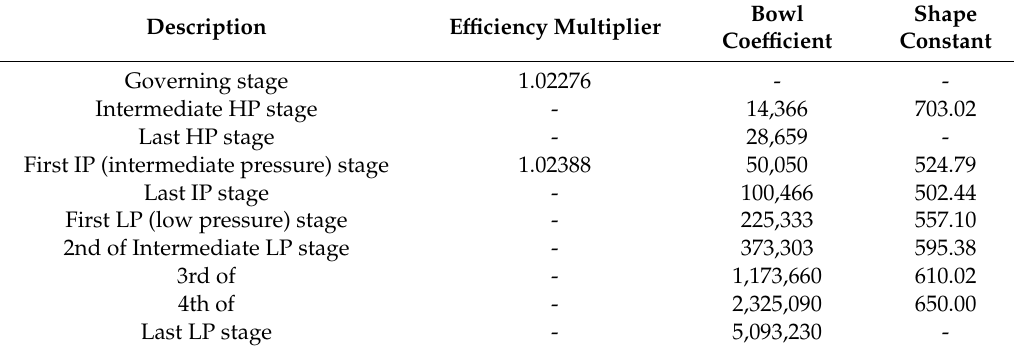
Table 3. Turbine performance